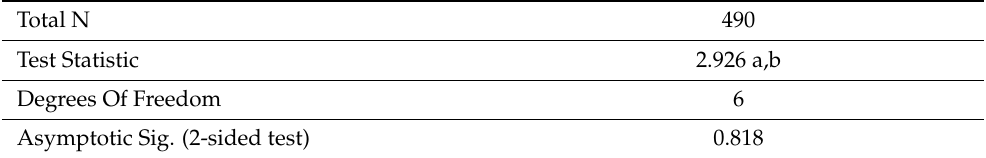
Table A8. Effects on error rate (lateral thinking abilities).